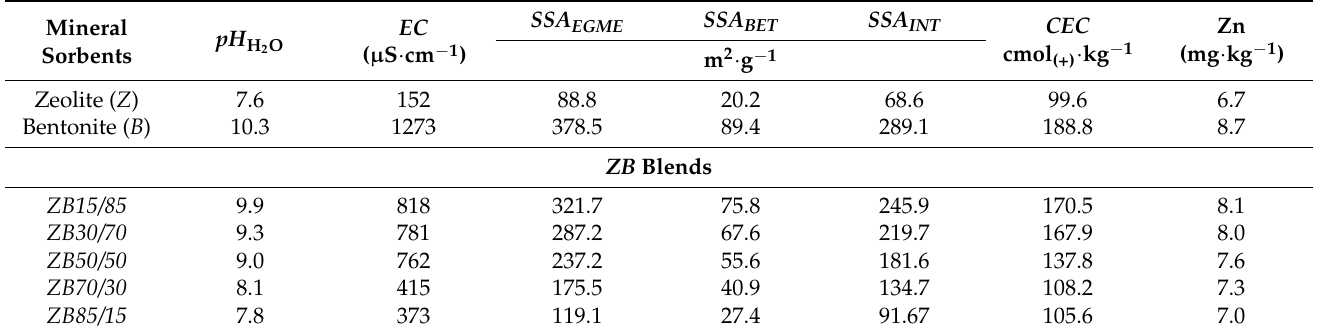
Table 2. Physical and chemical characteristics of zeolite, bentonite and the ZeoBen ( ZB ) blends. Mineral